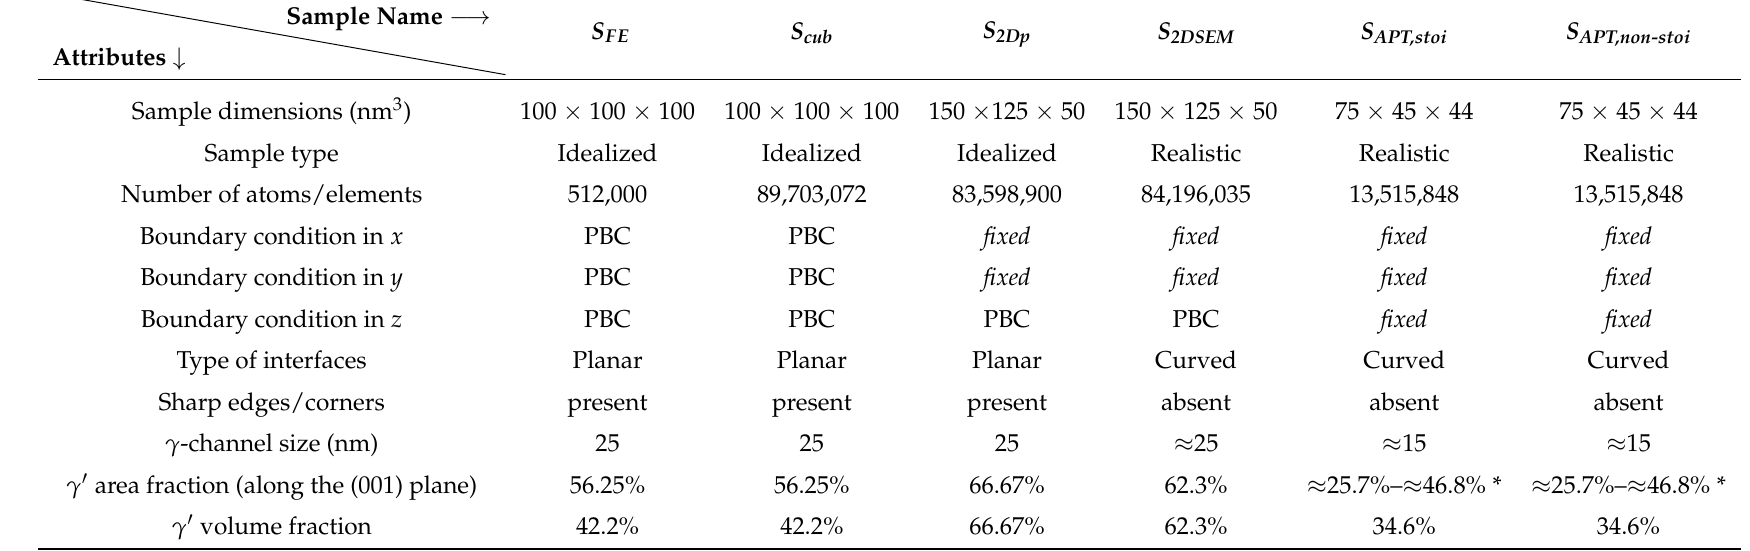
Table 1. Details on both the idealized and realistic γ / γ (cid:48) samples used in the current work. The γ (cid:48) volume fraction is computed using the number of atoms that constitute the γ (cid:48) phase. The area fraction is computed in a similar fashion, but by using a thin slice of atoms in the (001) plane. Note that for the APT-informed samples, the area fraction (marked * in the table) depends on the place where this slice is taken from, and hence, a range is provided. The sample S FE is the finite element sample, and all other samples are atomistic samples, which are grouped together for clarity. For a detailed description of the sample nomenclature, the reader is referred to the text in the